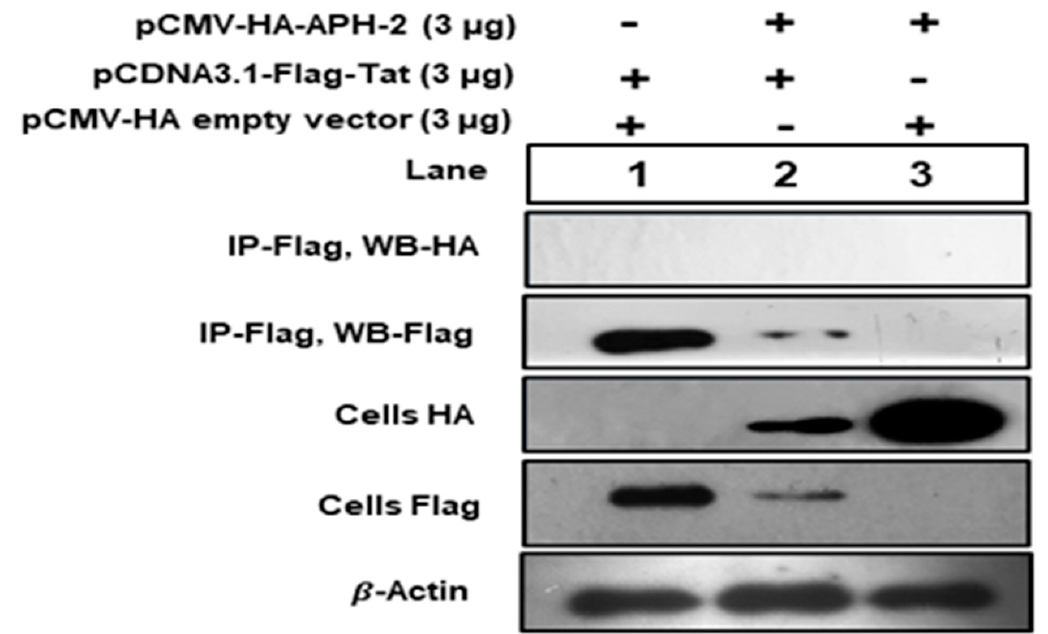
Figure 4. Immunoprecipitation of APH-2 and HIV-1 Tat association: 293T cells were co-transfected with HA-APH-2 (3 µ g) and pCDNA3.1 Tat-Flag (3 µ g), together and separately. Cell lysates were immunoprecipitated with anti-flag antibody, followed by Western blot with anti-HA. Cellular beta actin expression represents the loading control (+ and − sign used to represent presence and absence of plasmid used for transfection).